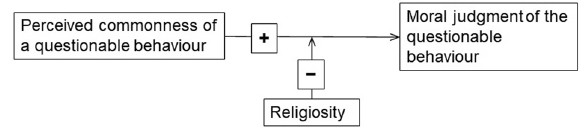
Fig. 9 Conceptual diagram of the hypothesis. Religiosity may negatively moderate the positive effect of perceived commonness on how moral a questionable behaviour is judged to be.